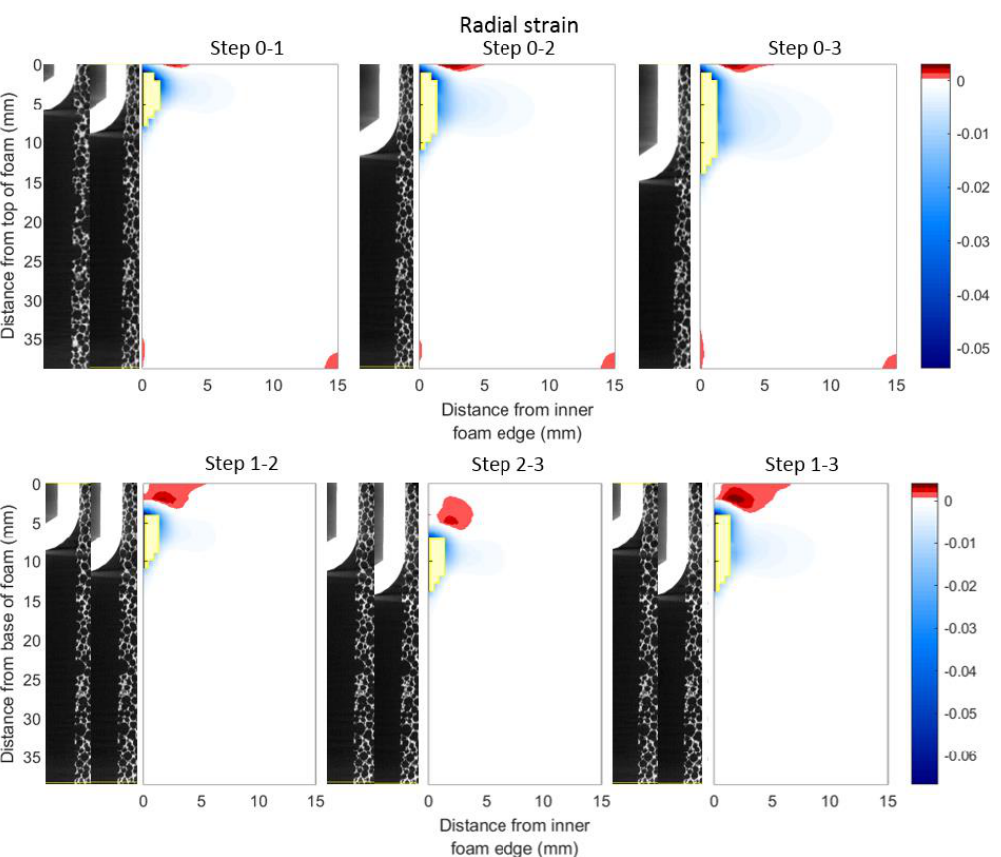
Figure 7. Radial strain fields (averaged circumferentially) for each displacement step relative to reference scan and sequential scans. The top row shows fields calculated from difference with the reference scan (the ‘0’ position); the bottom row shows fields calculated sequentially: between Scans 1 and 2, 2 and 3, and 1 and 3. Note each scan increment corresponds to a target displacement increment of 3.0 mm: Scan 1, 3.0 mm displacement; Scan 2, 6.0 mm displacement; and Scan 3, 9.0 mm displacement. Measurements with correlation coefficients below 0.9 have been excluded and their spatial locations are shown in yellow.